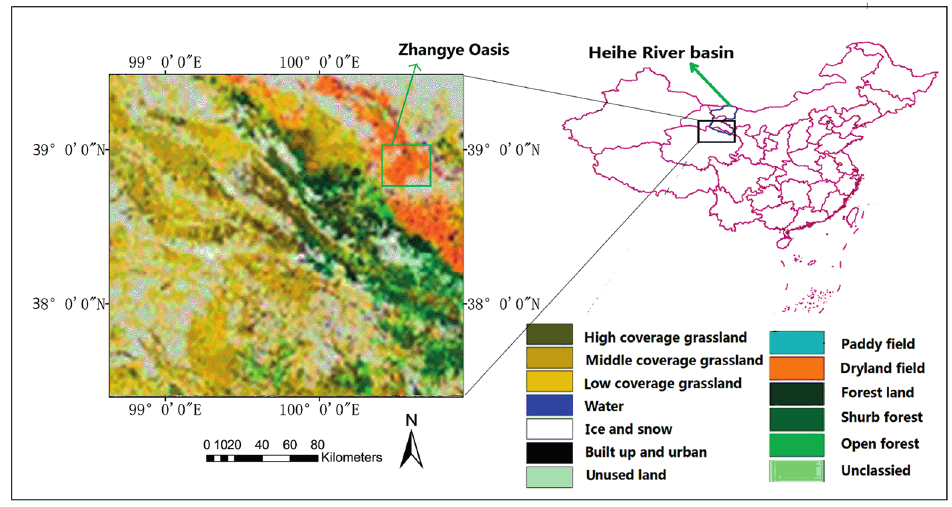
Figure 2. The location and the land cover of the study area. The small green rectangle in the map on the left is the Zhangye